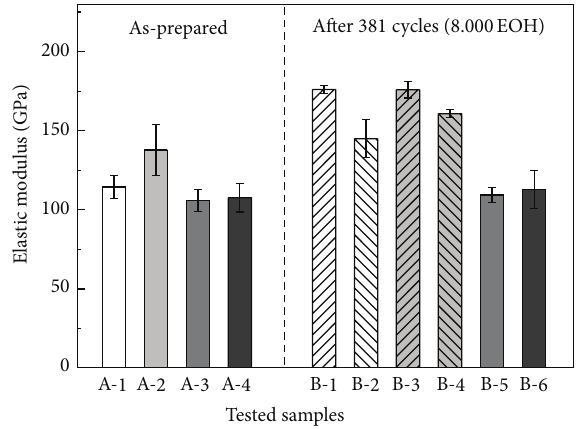
Figure 5: Elastic modulus values of TBCs before and after cyclic thermal exposure tests for 381 cycles: (A-1) APS bond coat, (A- 2) HVOF bond coat, (A-3) C-NS top coat, (A-4) NS top coat, (B- 1) and (B-2) APS bond coat with the C-NS and NS top coats, respectively, (B-3) and (B-4) HVOF bond coat with and without plasma pretreatment, respectively, (B-5) C-NS top coat, and (B-6) NS top coat. A and B series indicate the elastic modulus before and after cyclic thermal exposure tests for 381 cycles, respectively.